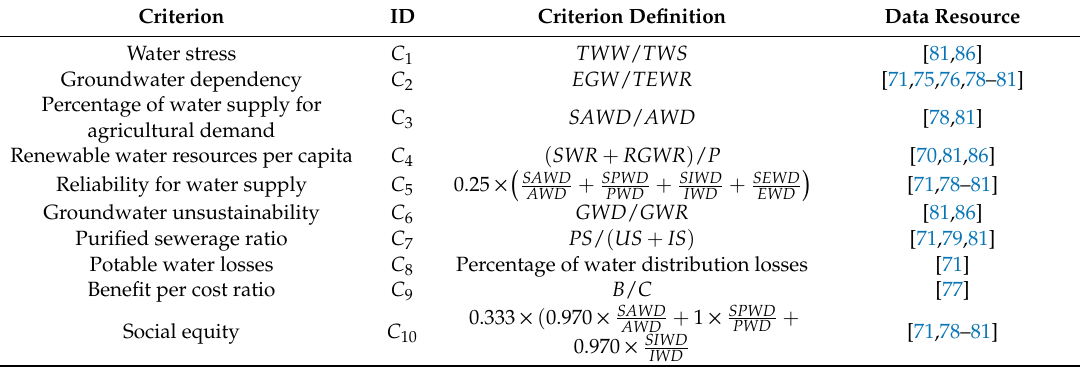
Figure 6. The group consensus measurements of the initial criteria for the Kashafroud watershed. In order to select the final criteria from the 21 initial criteria, the group consensus measurements that are higher than the determined TLA ( TLA = 0.800) are selected as the final criteria. According to Figure 6, the 10 black-filled criteria of C (cid:48) 1 , C (cid:48) 2 , C (cid:48) 5 , C (cid:48) 9 , C (cid:48) 12 , C (cid:48) 14 , C (cid:48) 16 , C (cid:48) 17 , C (cid:48) 18 , and C (cid:48) 21 have been selected as the final sustainable development criteria, which are the most preferable criteria in the group viewpoints for the decision-making process within the watershed. The final selected criteria that are marked by C 1 , C 2 , C 3 , C 4 , C 5 , C 6 , C 7 , C 8 , C 9 , and C 10 , are defined in Table 6 [82–85]. Table 6. The final sustainable development criteria for the Kashafroud watershed by the 2040 vision. TWW is the total water withdrawal (includes urban, agricultural, and industrial and water withdrawal); TWS is the total water storage; EGW is the exploitation from groundwater; TEWR is the total exploitation of water resources ( TWW + environmental water withdrawal); SAWD is the supplied agricultural water demand; AWD is the agricultural water demand; SWR is the surface water resources; RGW is the renewable groundwater resources; P is the population; SPWD is the supplied potable water demand; PWD is the potable water demand; SIWD is the supplied industrial water demand; IWD is the industrial water demand; SEWD is the supplied environmental water demand; EWD is the environmental water demand; GWD is the groundwater discharge; GWR is the groundwater recharge; PS is the purified sewerage; US and IS are the urban sewerage and industrial sewerage, respectively; and B and C are the amount of benefit and cost values of the implementation of the water strategies,